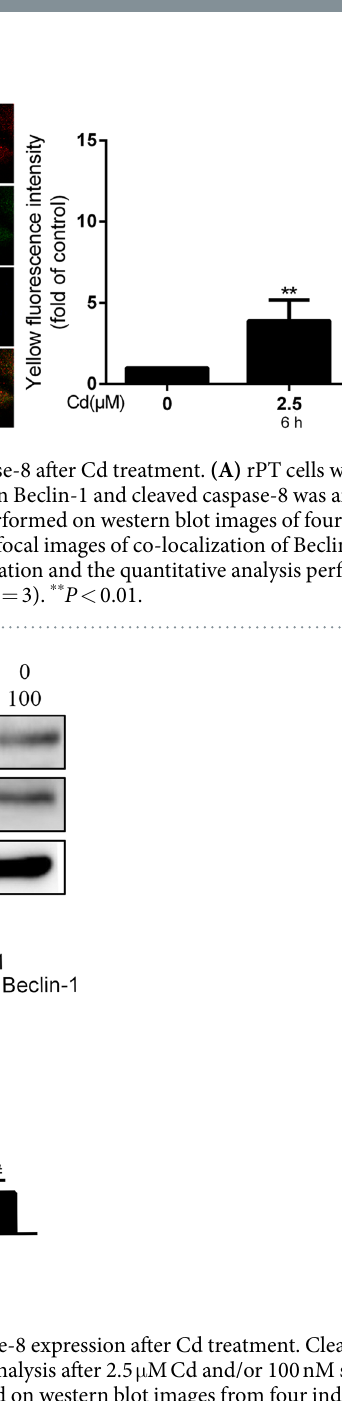
Effect of Beclin-1 silence on cleaved caspase-8.